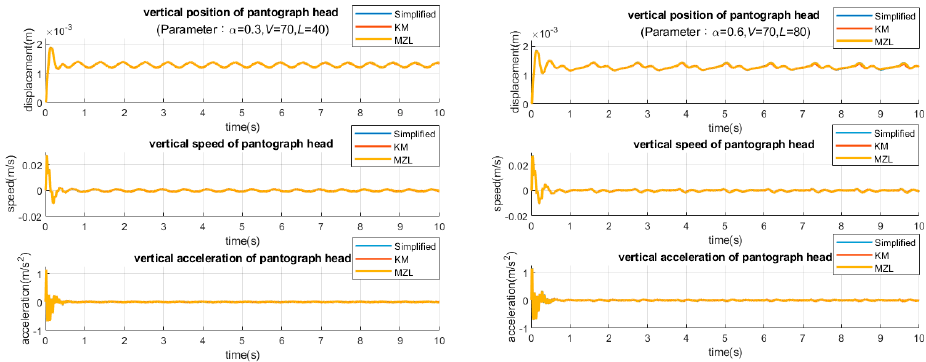
Figure 9. The contact force regulation performance for IT2AFLC with three different type reduction methods.